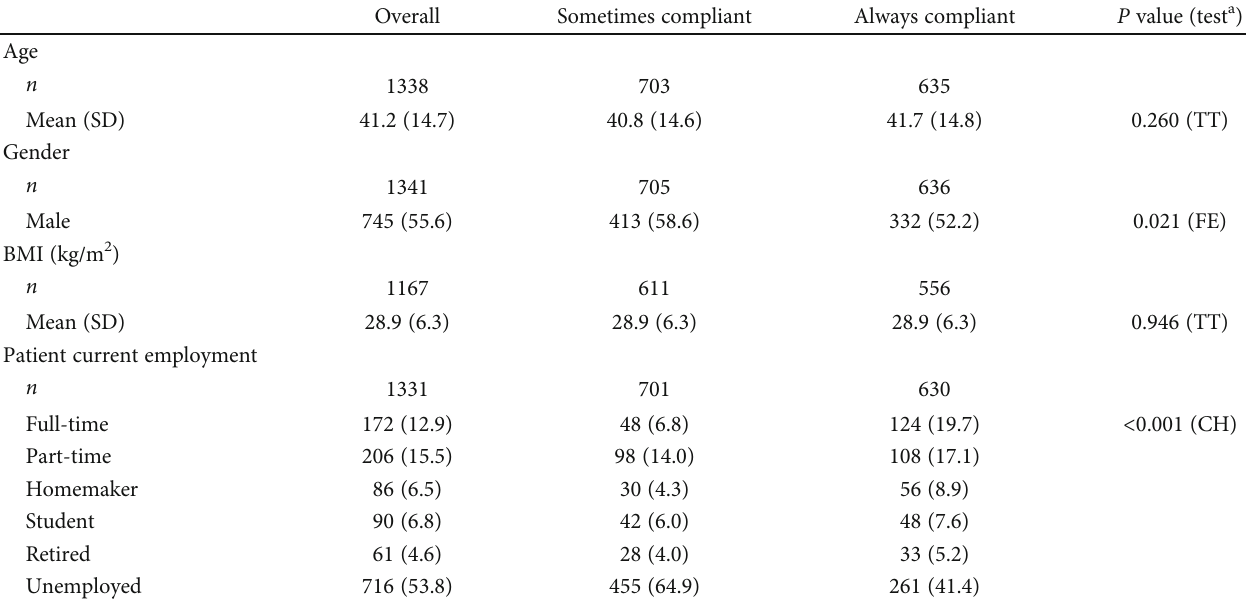
Table 1: Patient